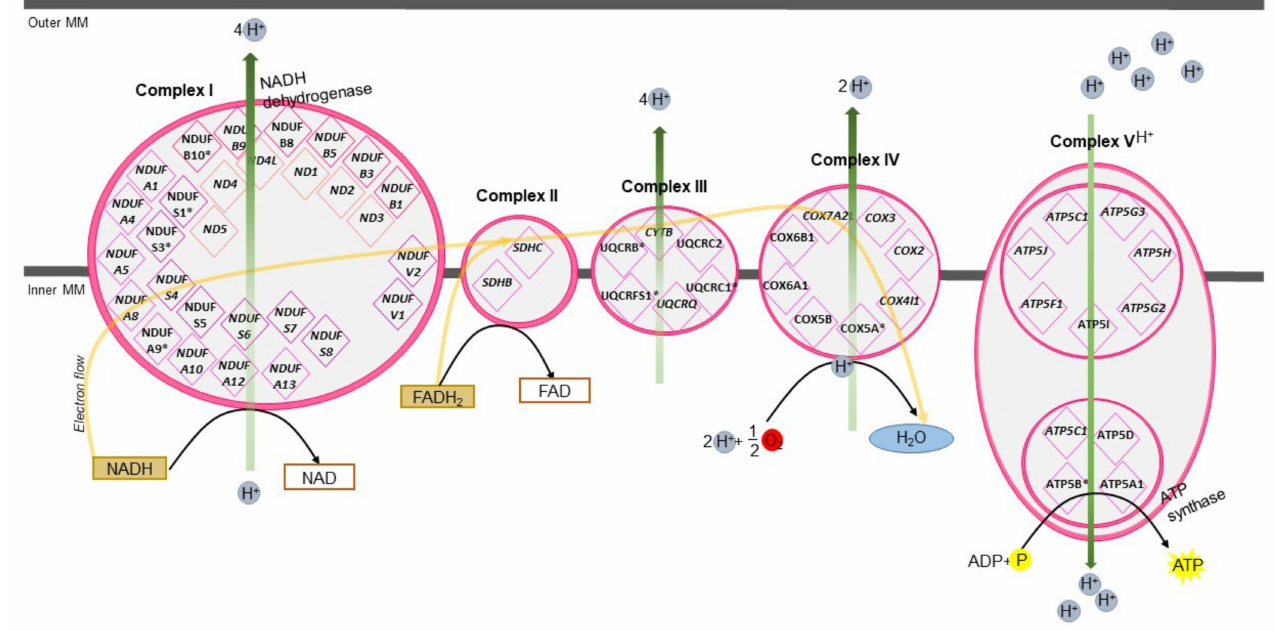
Figure 7. Transcripts/proteins identified in the inner perivitelline layer which participate in the mitochondrial oxidative phosphorylation complexes I–V. Description of gene/protein symbols are presented in the Supplementary Materials, Tables S1 and